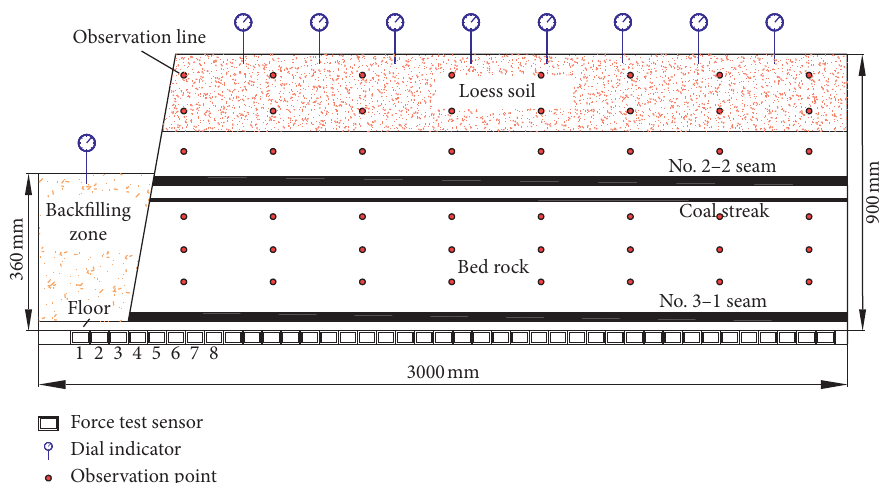
Figure 3: The physical simulation model.